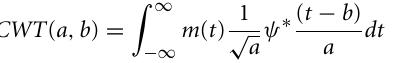
power]— min [Gamma-band power] in the [0:500] ms window from choice screen onset) during early (blue) and late (red) trials. There was a significant reduction in gamma frequency band amplitudes in the late trials compared to the early trials ( p = 0 . 003, rank sum test). There was no significant trend in the distribution of peak-to-peak broadband signals between early and late trials in the same electrode ( p = 0 . 14, rank sum test). (E) Modulation index (MI) curve (difference between the mean gamma frequency band amplitudes in the early trials and subsequent trials, Materials and Methods), computed by using 20-trial sliding bins stepped by one trial, showing a decrease in gamma frequency band amplitude concomitant with the subject’s performance improvement shown in b (mean MI: − 0 . 19 ± 0 . 006 [mean ± SEM]). The horizontal line represents MI = 0 (i.e., no change in gamma frequency band